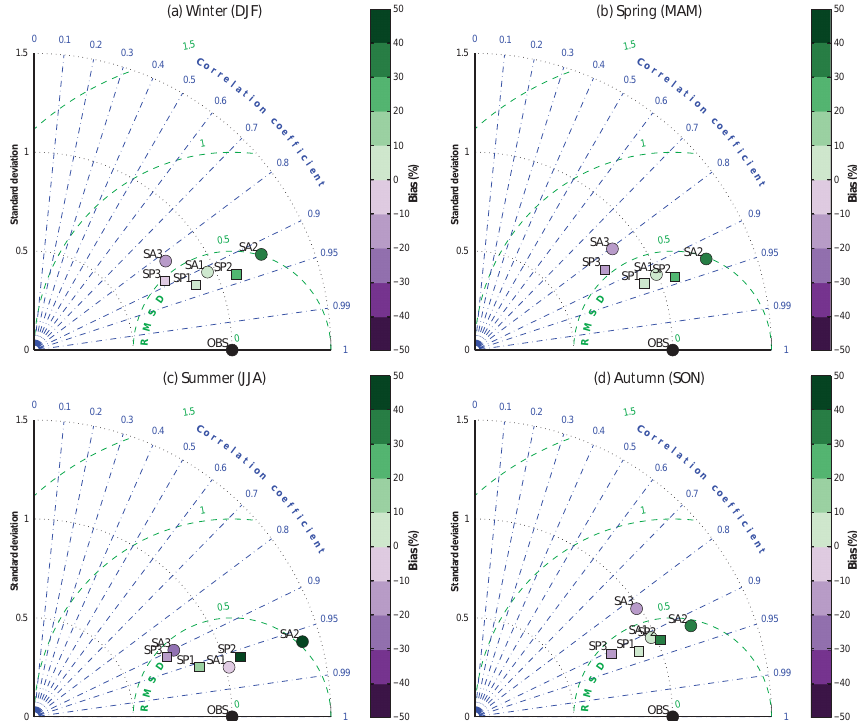
Figure 6. Taylor diagrams for the seasonal precipitation climatology over Spain. The points most similar to the station data are closest to the point indicated as OBS. The squares labeled SP are used for Spain02, whereas the circles labeled SA are for SAFRAN. The colors indicate the bias (in percentage with respect to the station data) of the dataset. The numbers correspond to the different indices: 1 is PRCPTOT, 2 is R1 and 3 is